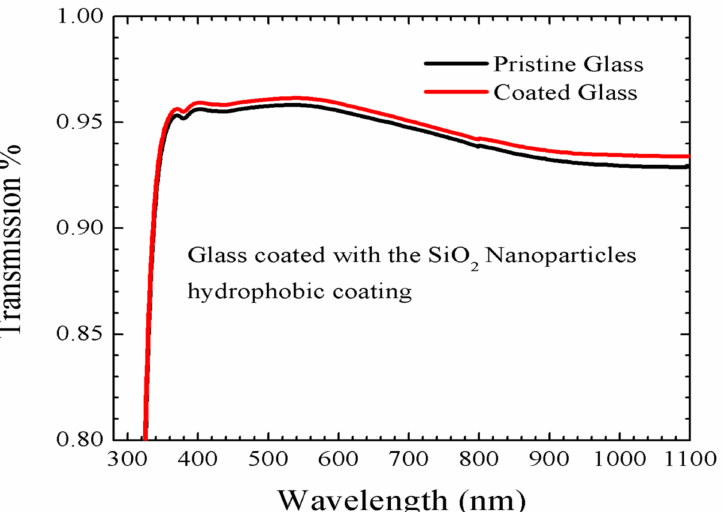
Figure 10. Transmission spectra of pristine glass and coated glass with SiO 2 hydrophobic nanoparticles.